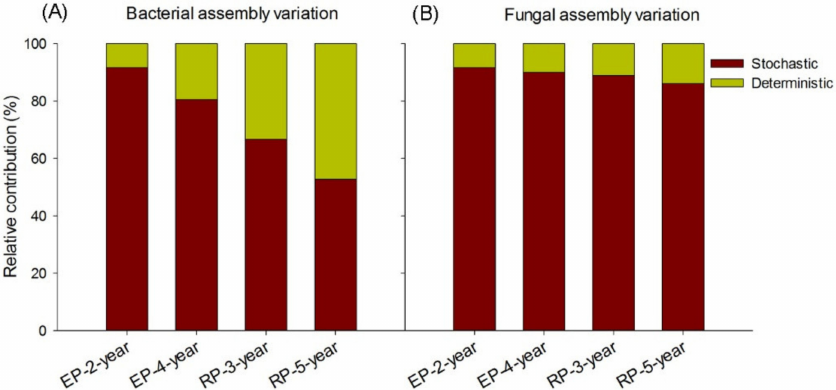
Figure 5. The relative contributions of environmental selection and stochastic processes on soil microbial community assembly in 2-year-old and 4-year-old Eucalypt plantations (EP-2-year and EP-4-year) and 3-year-old and 5-year-old Rubber plantations (RP-3-year and RP-5-year). ( A ) The relative contributions of stochastic and deterministic processes on bacterial community assembly. ( B ) The relative contributions of stochastic and deterministic processes on fungal community